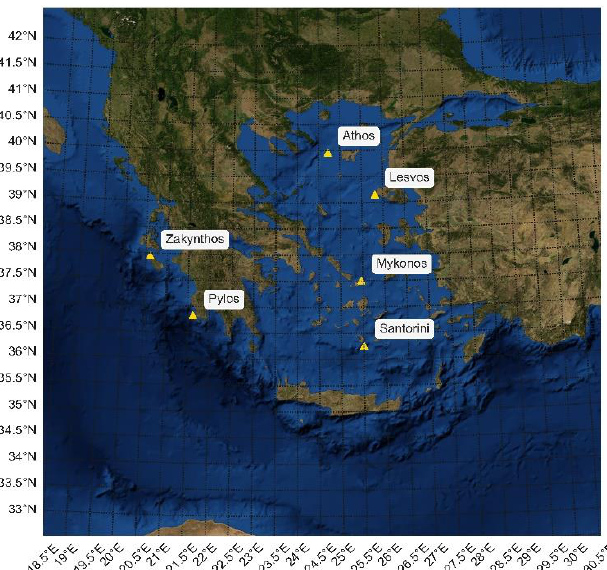
Figure 1. Location of the POSEIDON buoys.